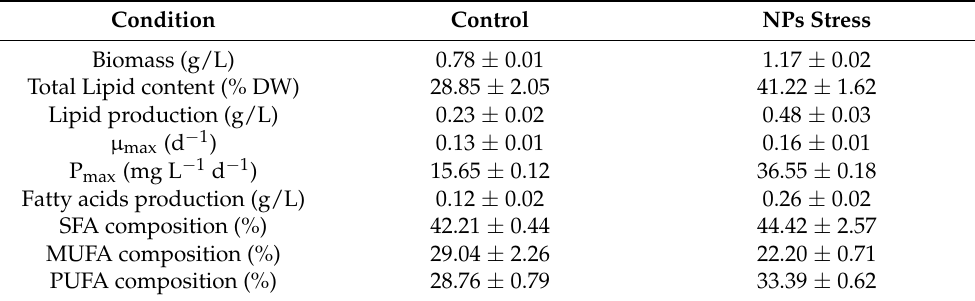
Table 2. Biomass, lipid content, lipid production, maximum specific growth rate ( µ max ), and maxi- mum lipid productivity (P max ) of Chlorella sp. UJ-3 under control and NP stress.